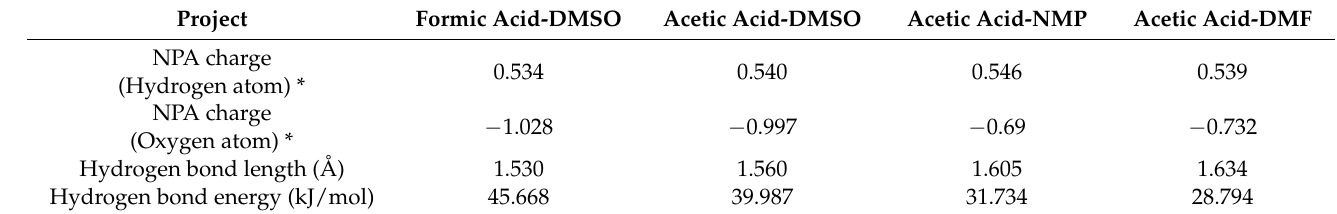
Figure 6. Schematic diagram of the hydrogen bond length formed by acetic acid and three solvent molecules, and the NPA charge of each atom. Table 3. NPA charges of hydrogen bond atoms, hydrogen bond length, and